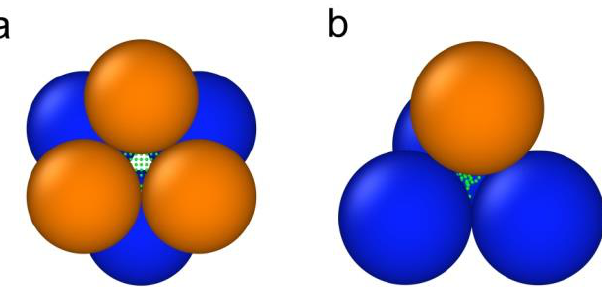
Figure 4. The cartoon view of spherical phase II elements within octahedral ( a ) and tetrahedral ( b ) pores. Table 1. Parameters of the model, corresponding to the fit in Figure 3.